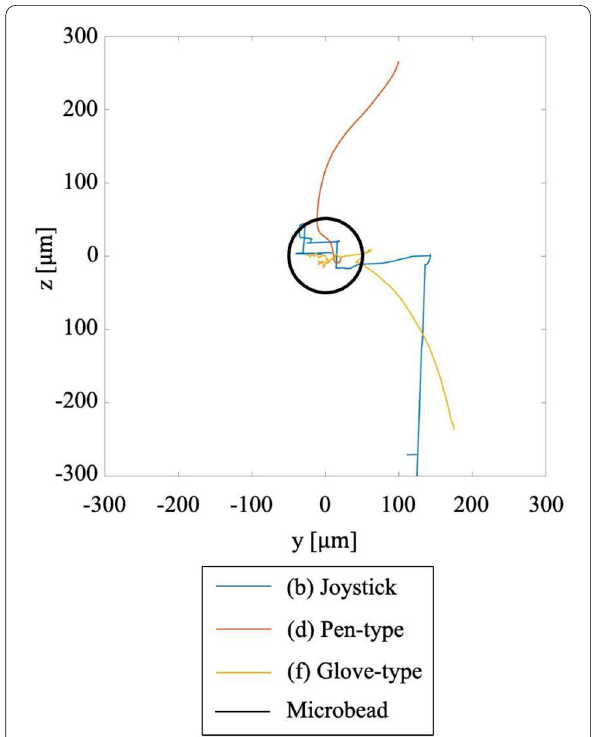
Fig. 23 Trajectories in the xz -plane with 3D image presentation for the evaluation of operation accuracy